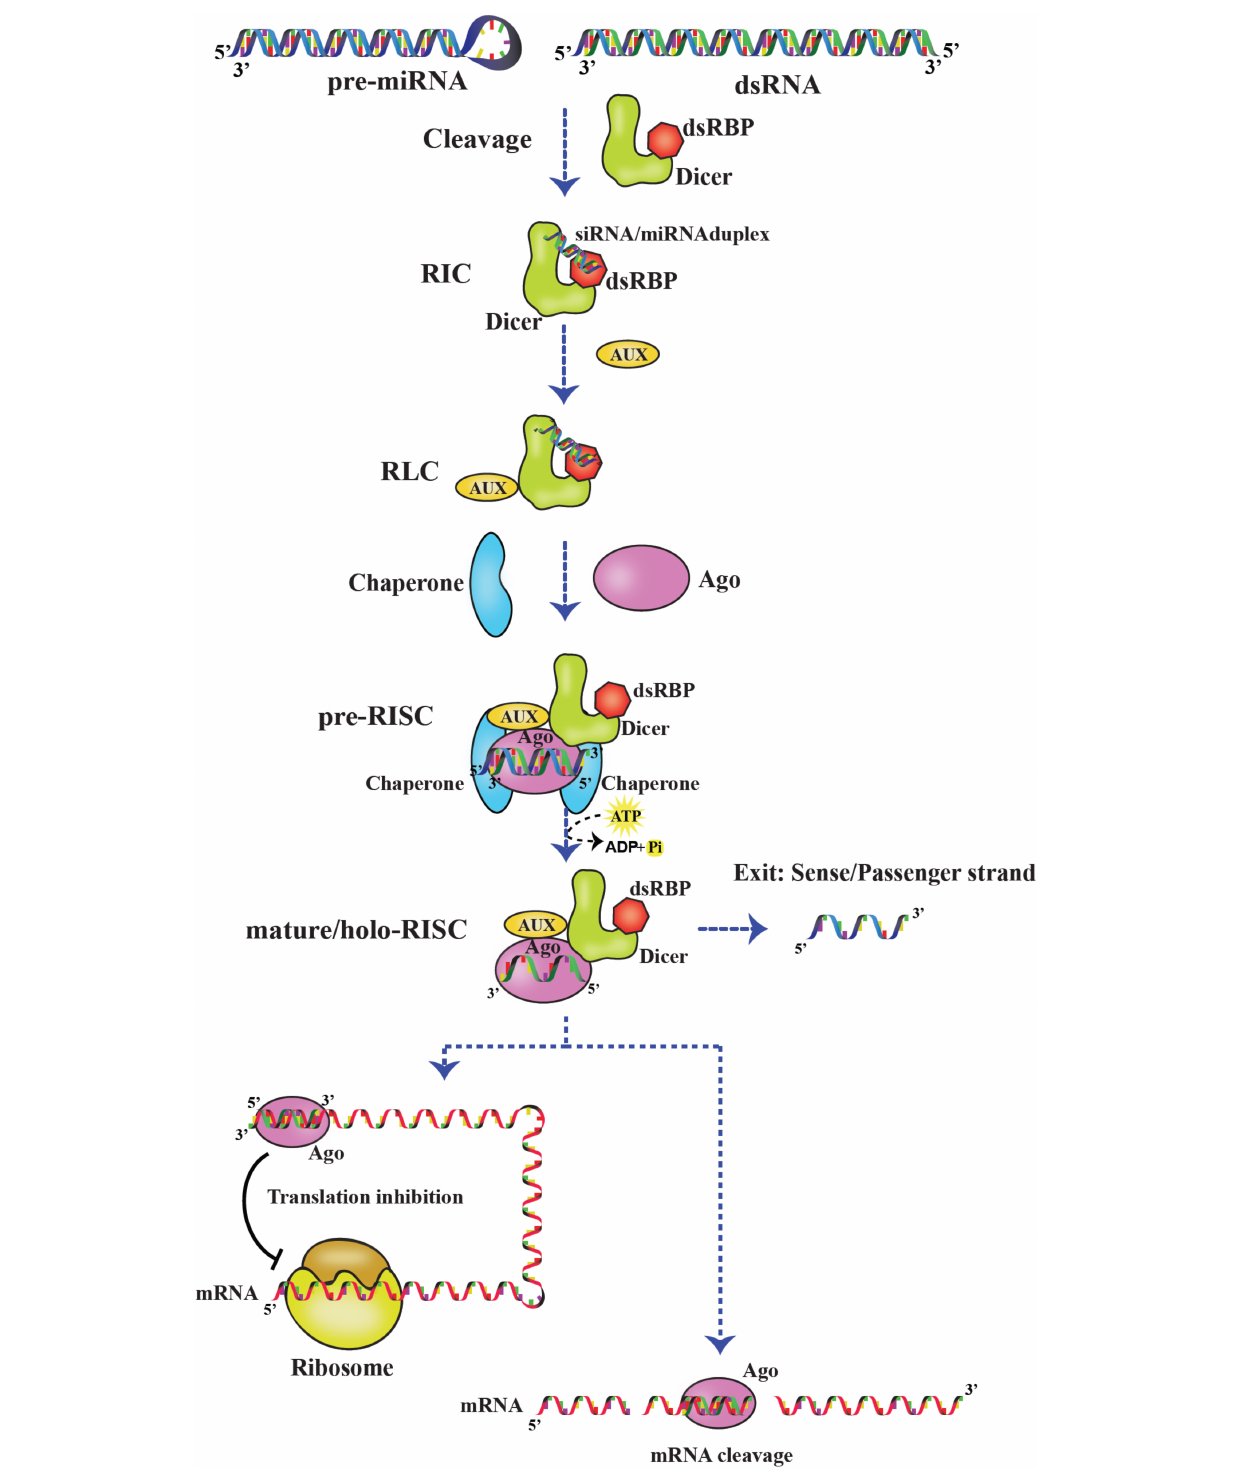
Frontiers in Molecular Biosciences |